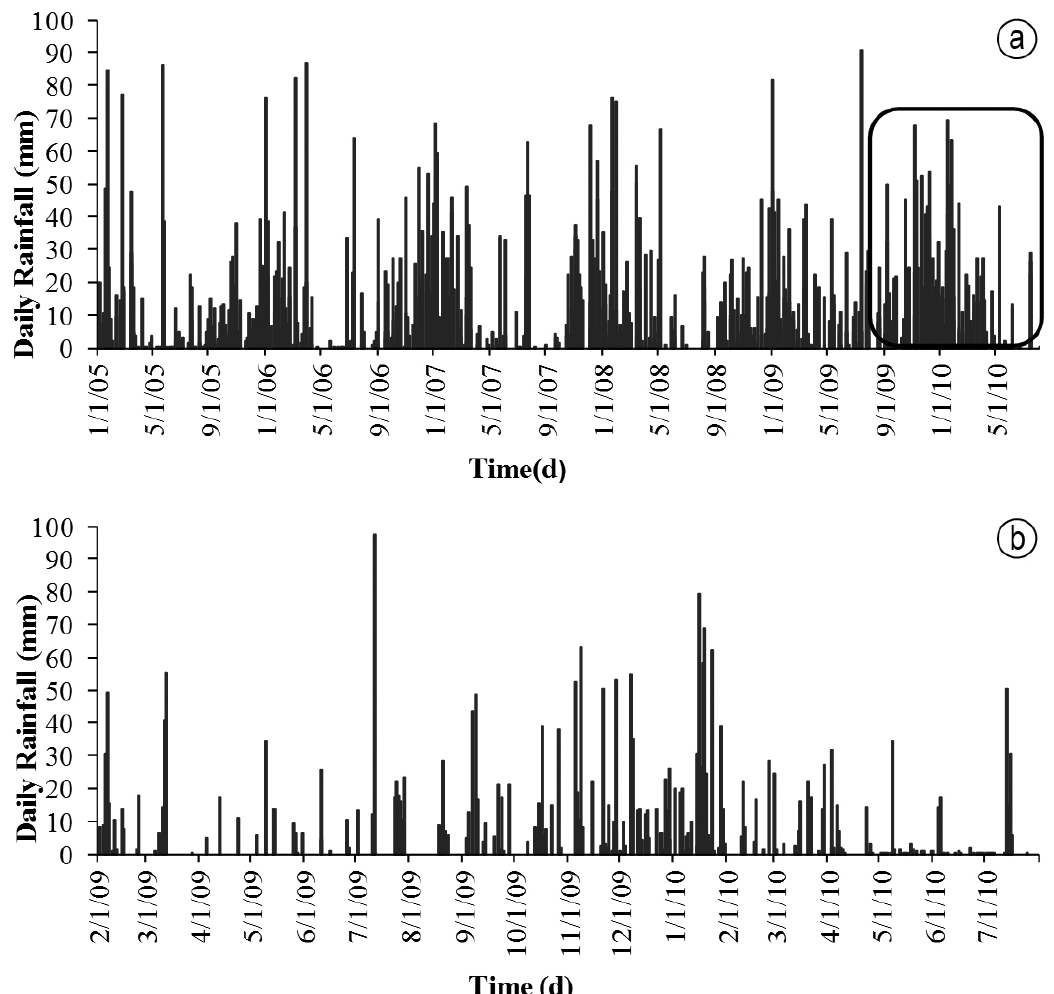
Figure 2. Rainfall in Itupararanga Reservoir: a) Five years daily rainfall with the study period outlined; b) rainfall during the study period (Winter-August/2009; Spring-October/2009; Summer-February/2010;